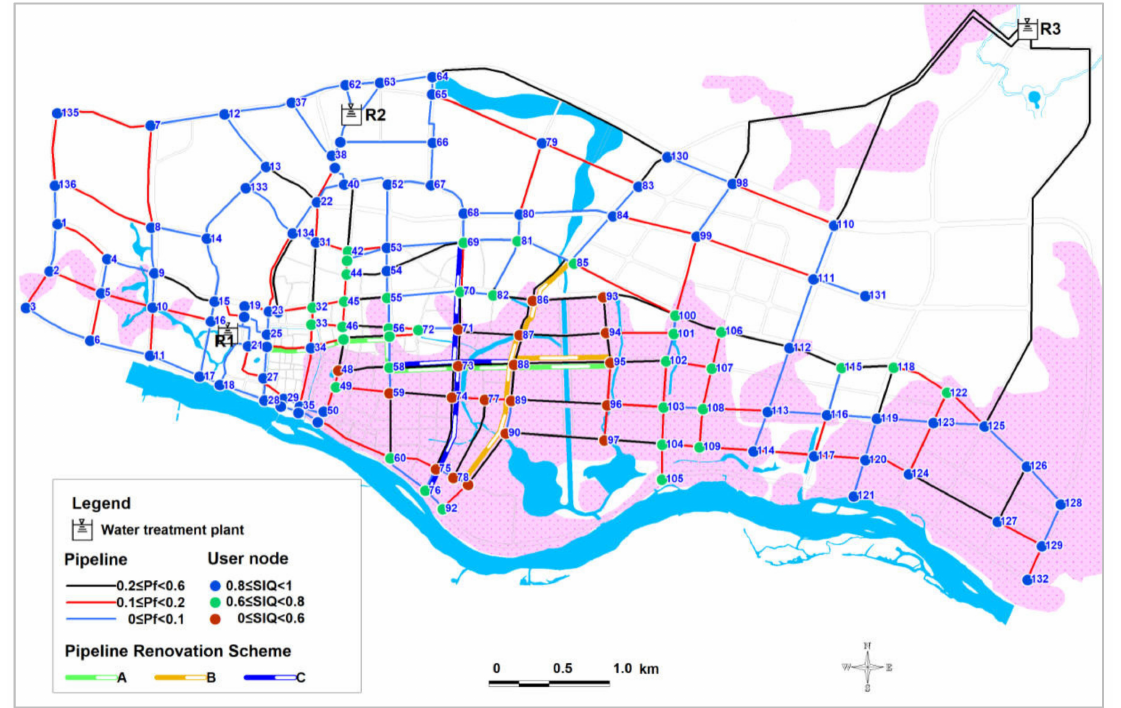
Figure 13. Seismic performance of the original WDS and the pipeline renovation